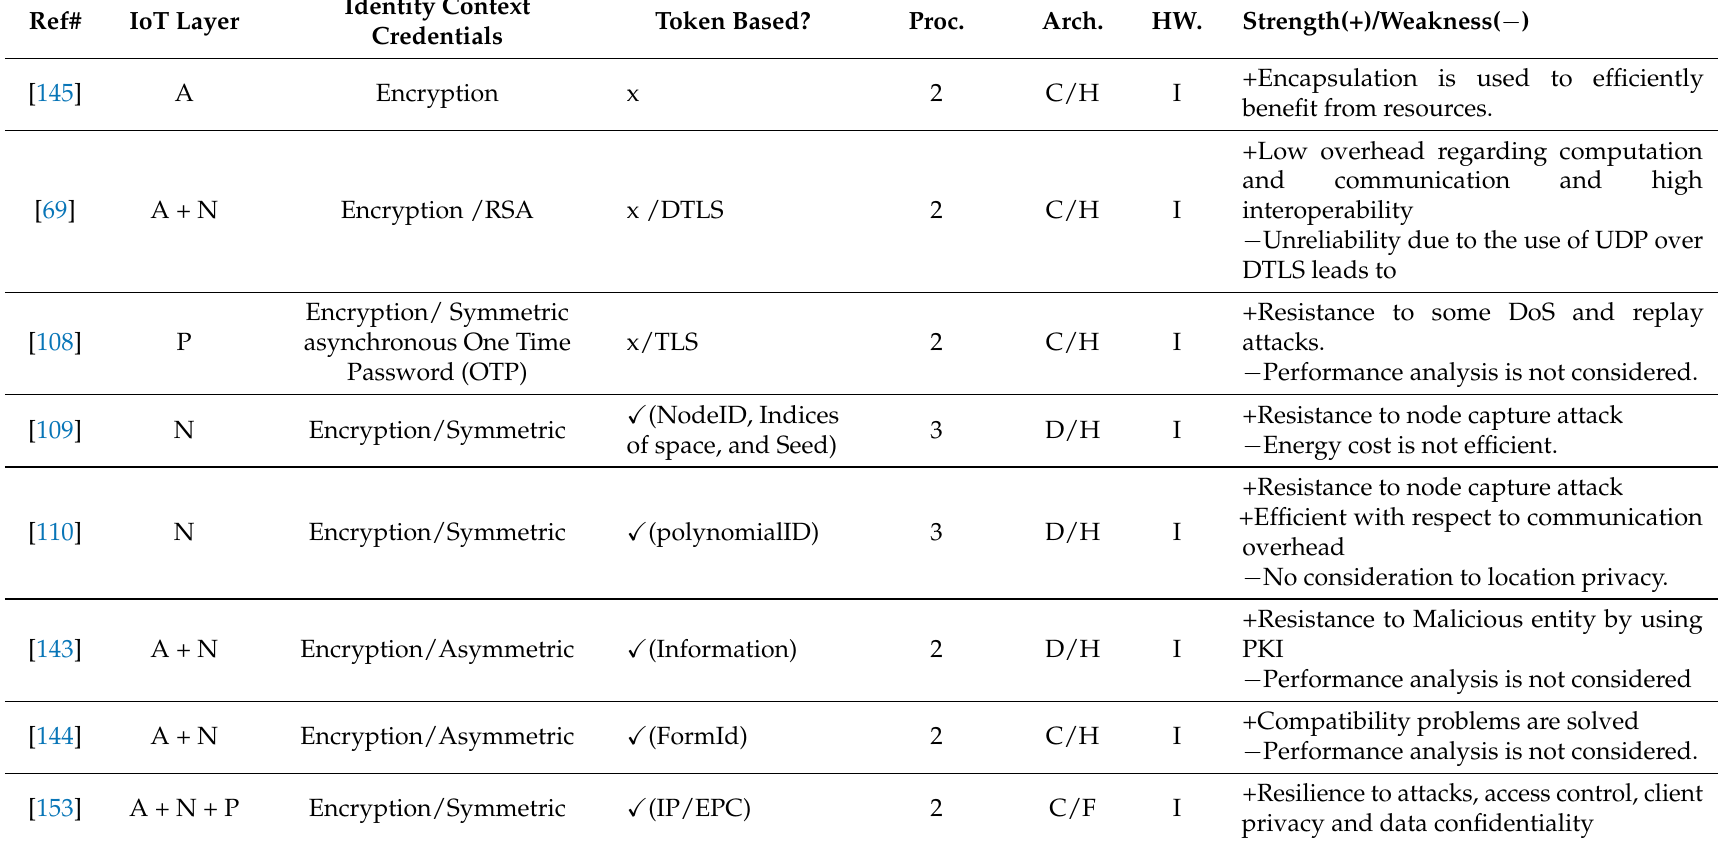
Table 2. Analysis of IoT Authentication